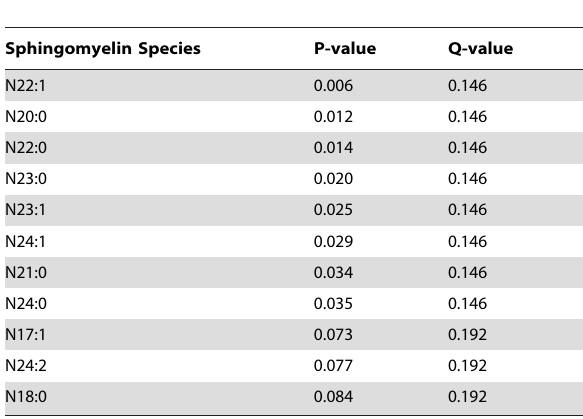
Table 3. Sphingomyelin species significantly different between AD and control groups a